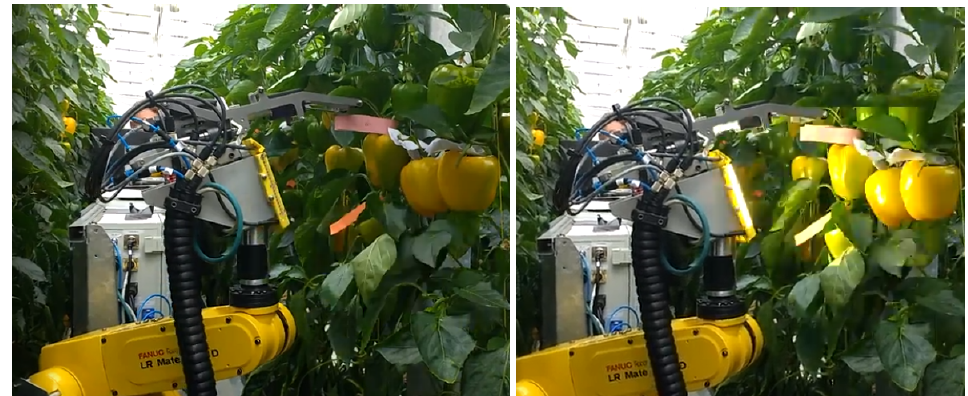
Figure 1. Experimentalsetting for FNF image acquisition; the same image is taken twice, with ( right ) and without ( left ) artificial light.